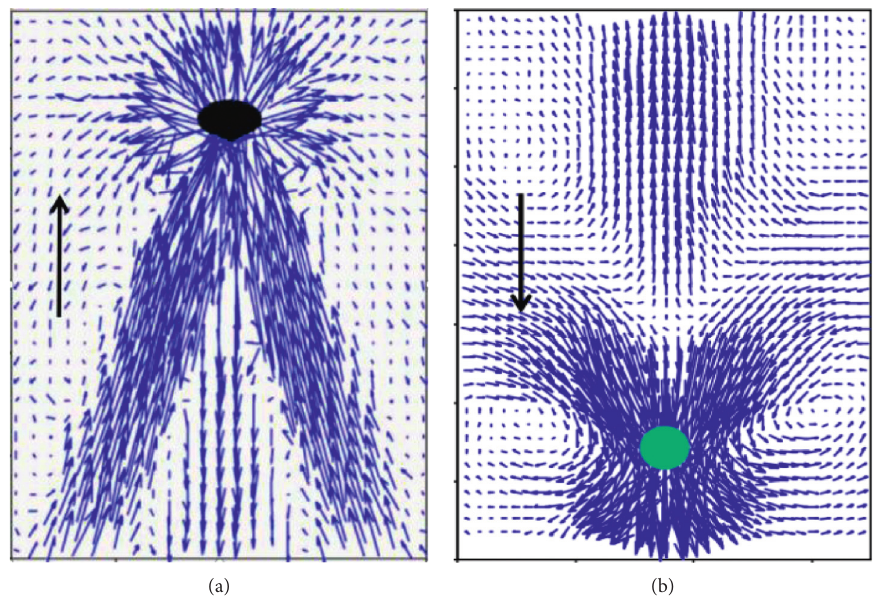
Figure 9: The negative wake around (a) a bubble and (b) a solid sphere in viscoelastic fluids